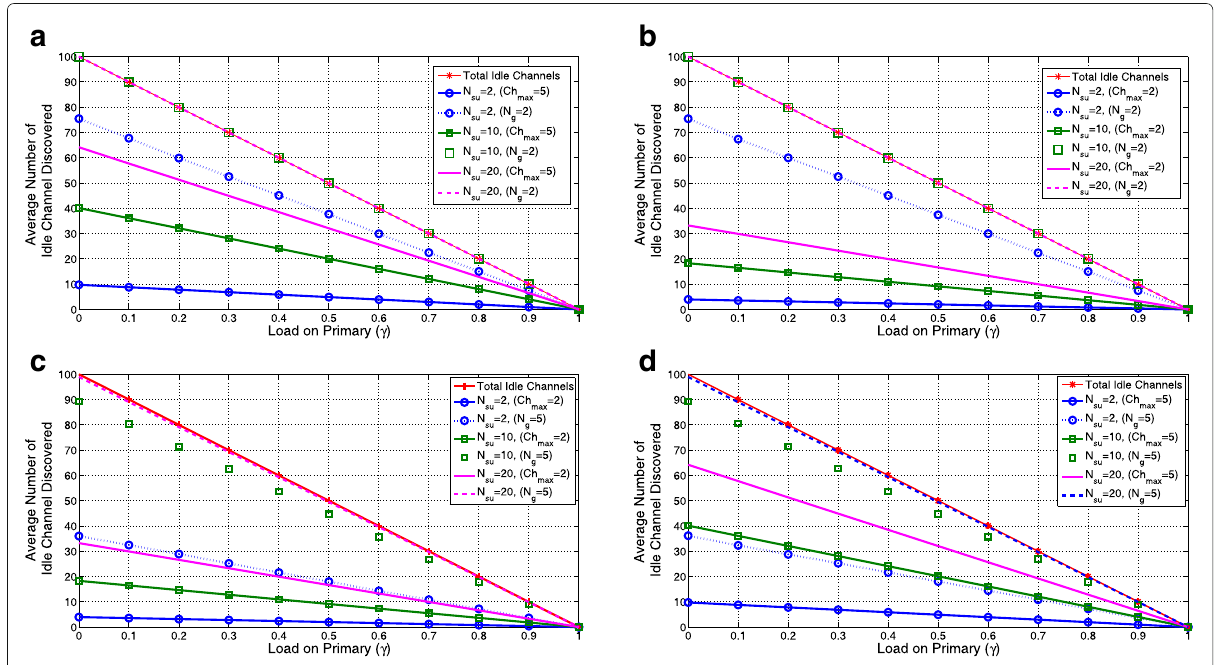
Fig. 8 Comparison of average number of idle channels discovered by SUs when a ch max = 5 and N g = 2, b ch max = 2 and N g = 2, c ch max = 2 and N g = 5, d ch max = 5 and N g = 5